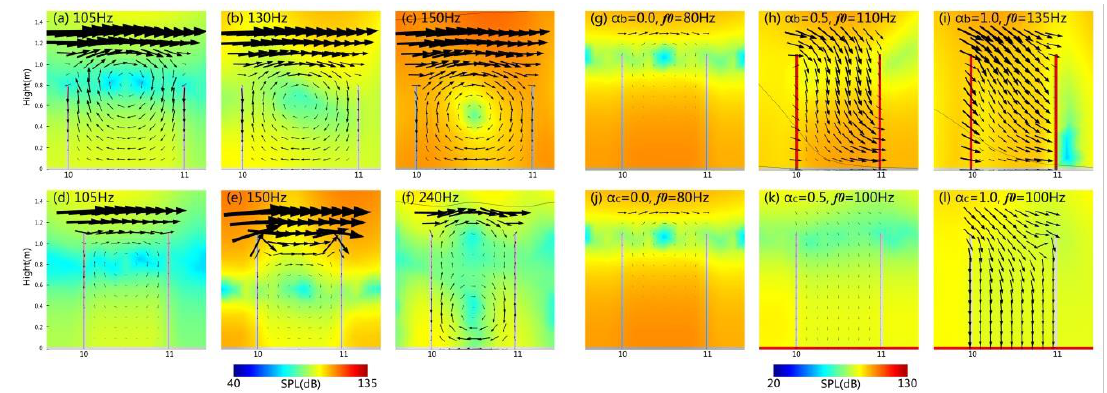
Figure 6. The SPL and SI distribution inside seat gaps: ( a – c ) seats are rigid, h = 0.8 m, and w = 1.1 m; ( d – f ) seats are rigid, h = 1.1 m, and w = 0.8 m; ( g – i ) α c = 0.0, h = 1.1 m, and w = 0.8 m; ( j – l ) α b = 0.0, h = 1.1 m, and w = 0.8 m.